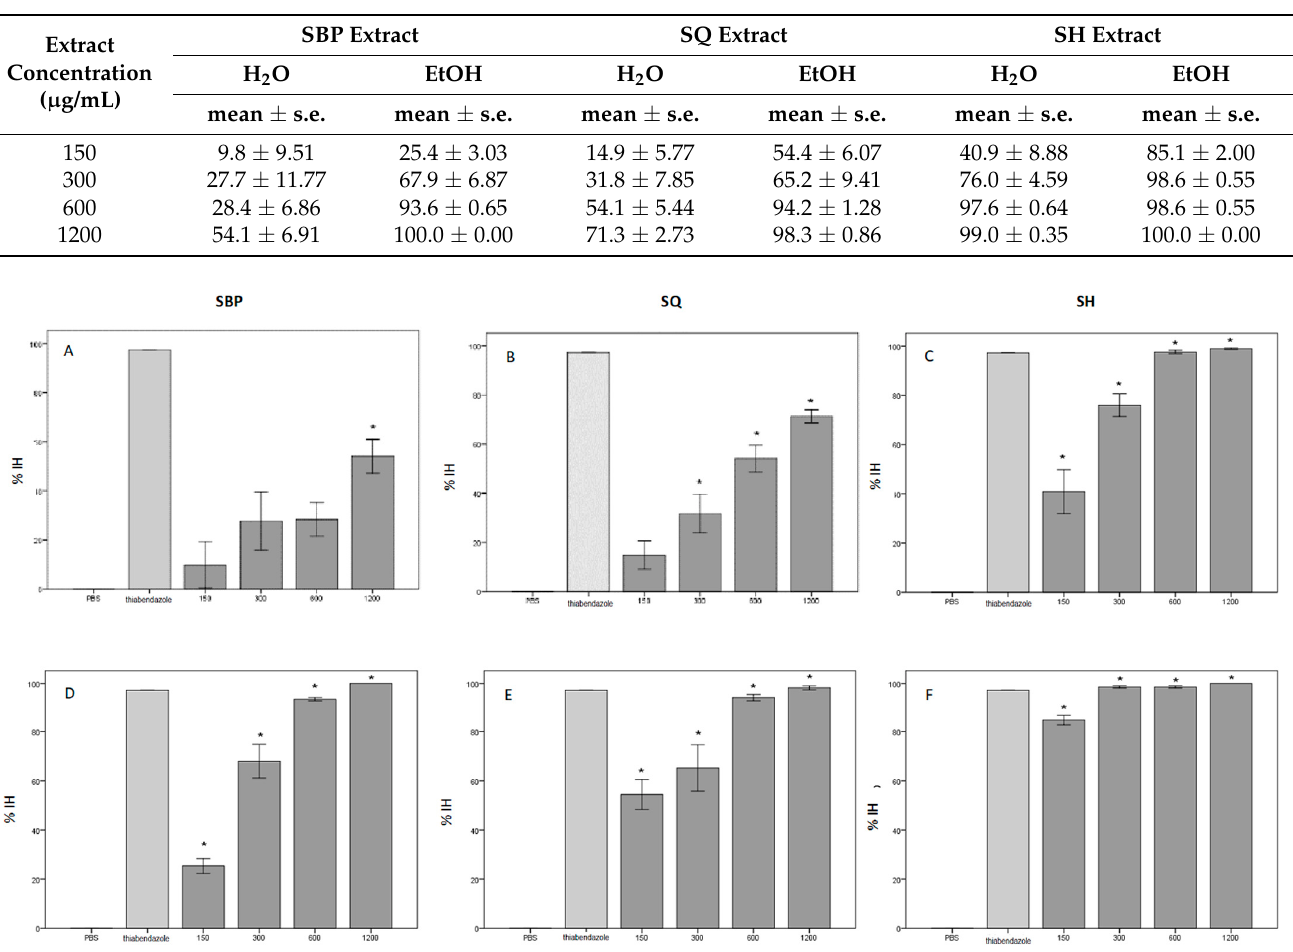
Table 1. Descriptive data obtained with the egg hatch test (EHT) on the three products tested (extract concentrations: 150, 300, 600, and 1200 μ g/mL, 4 replicates). The mean counts relating to the first stage larvae (L1) obtained for the replicates are reported. H 2 O: water extract; EtOH: ethanol extract; SBP: Silvafeed BYPRO; SQ: Silvafeed Quebracho powder; SH: Sainfoin hay; s.e.: standard error.